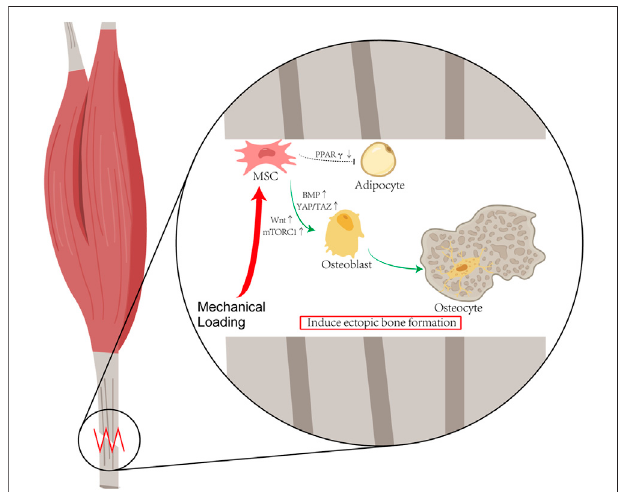
FIGURE 1 | Hypothesis of Mechanical Stimulation of HO: Mechanical stressinitiatesosteogenic differentiation ofmesenchymalstemcells (MSCs) in soft tissue. Stem cell fate of MSCs shifts from favoring lipogenic cells to osteogenic cells under mechanical loading. According to the published literature about HO, after the mechanical loading, the activations of the YAP/ TAZ and mTORC1 pathway enable MSCs to differentiate into osteoblasts, andthedecrease inPPAR γ expressionreducesthedifferentiationofMSCinto